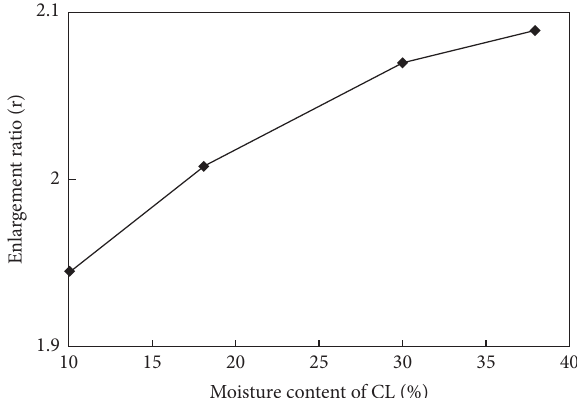
Figure 5: Enlargement ratio of textile sludge after S/S treatment.